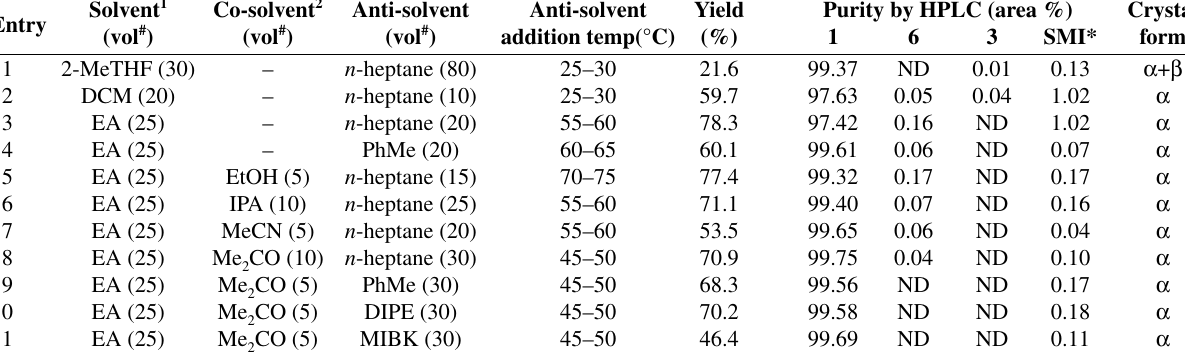
Table 1. Screening of solvents and anti-solvents for isolation of α -form crystals of 1